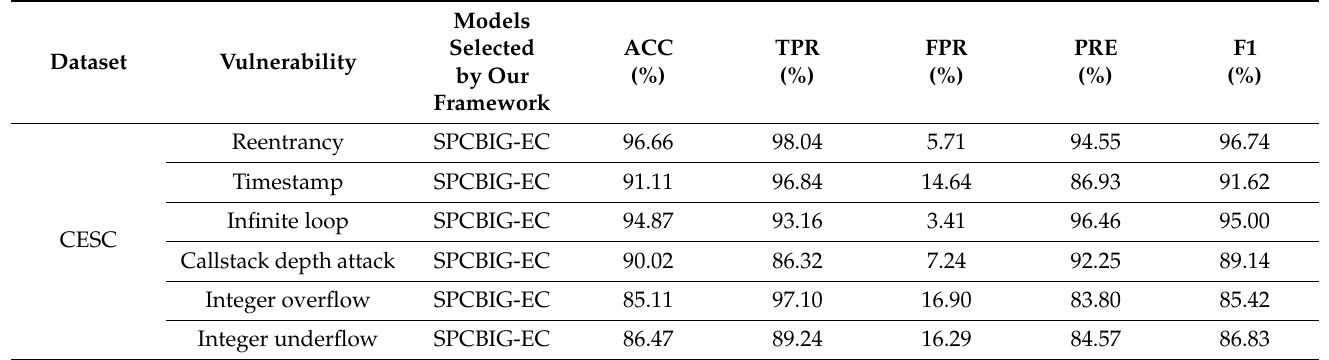
Table 3. The key points corresponding to different